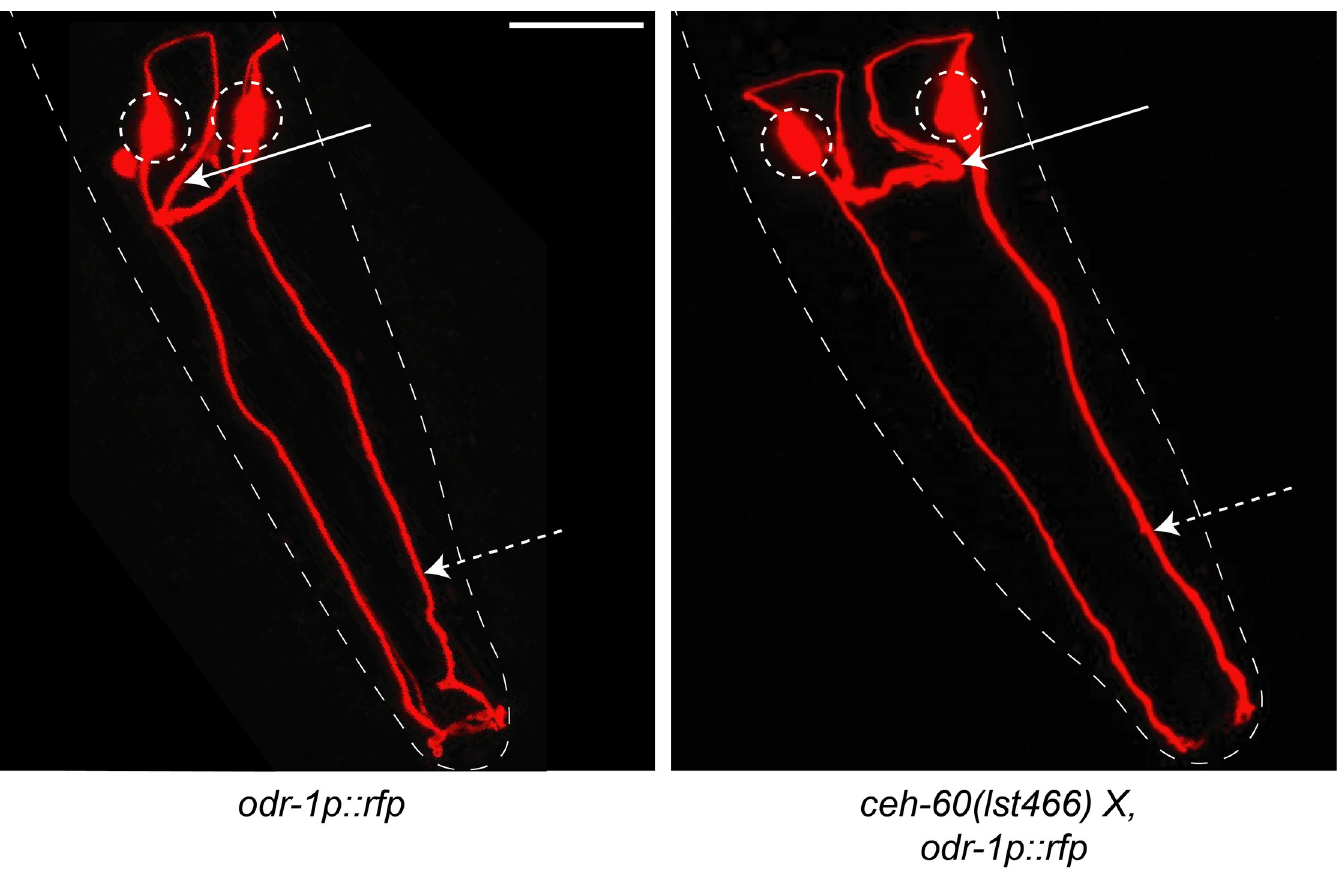
Fig 2. Morphology of AWC neurons in the head of control and ceh-60(lst466) mutant animals is similar. All animals carry the AWC-specific odr-1p :: rfp fluorescent marker. We found no clear difference in morphology of the AWC neurons between mutants and controls. In both cases, the neuron bodies (dashed circles) are clearly formed and extend their projections towards the sensory tip of the nose (dashed arrows) and the nerve ring (solid arrows). Outline of animals is shown as a dotted white line. Scale bar = 20 μ m. Both animals are L4 larvae.